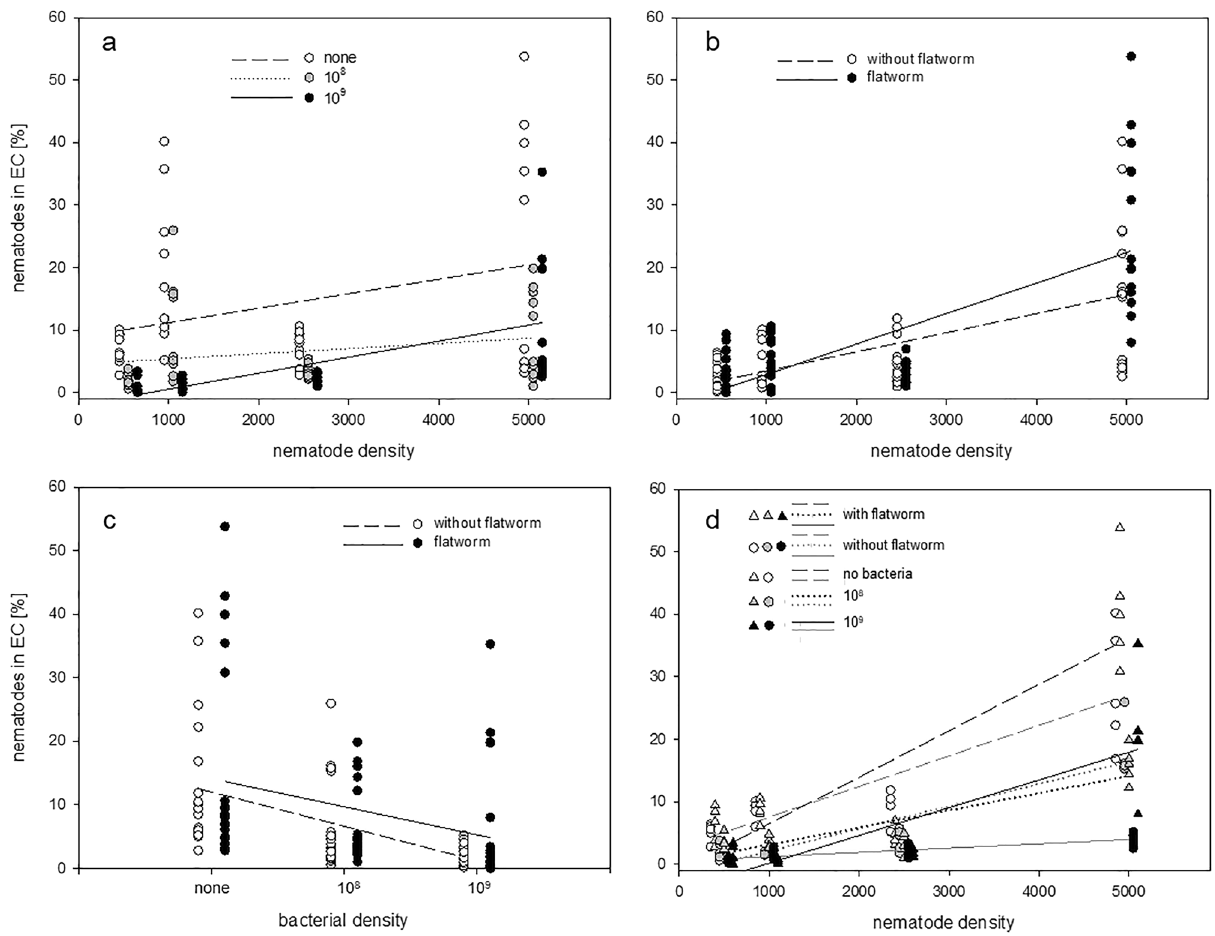
Figure 4. Percentages of all nematodes in the SCs that reached the ECs after 12 h for the combined predictors ( a ) nematode density and bacterial concentration, ( b ) nematode density and presence of predator, ( c ) bacterial density and presence of predator, and ( d ) the triple interaction of all